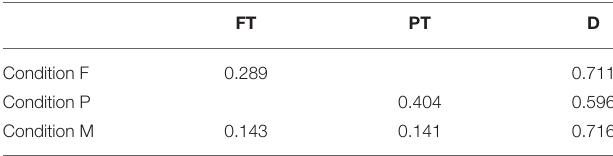
TABLE 3 | Fixation frequencies averaged over participants for foveal (FT) and peripheral targets (PT) and distractors (D) in the three experimental